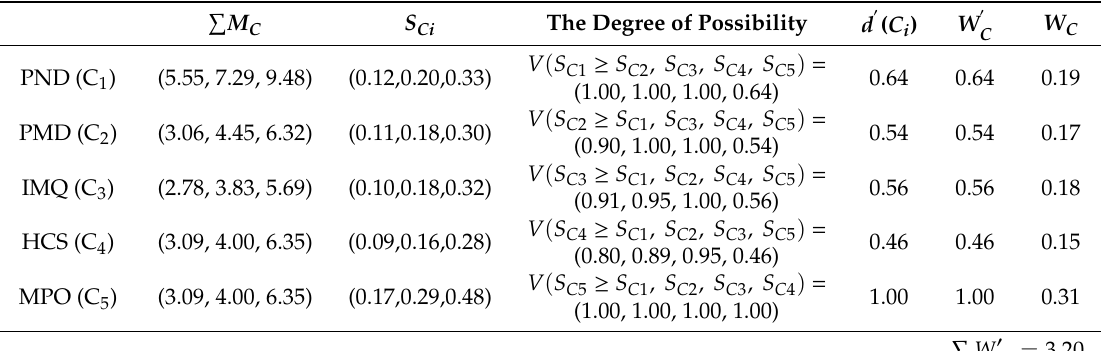
Table 7. The weight vector of C 1 -C 5 with respect to O 1.